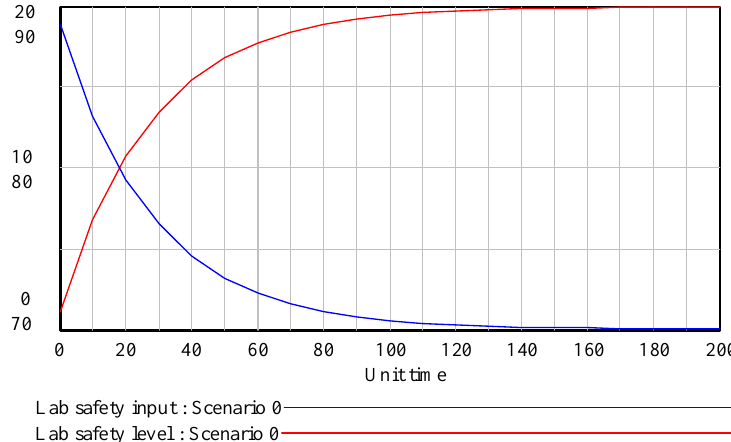
Figure 7. Dynamic relationship between laboratory safety level and safety input.